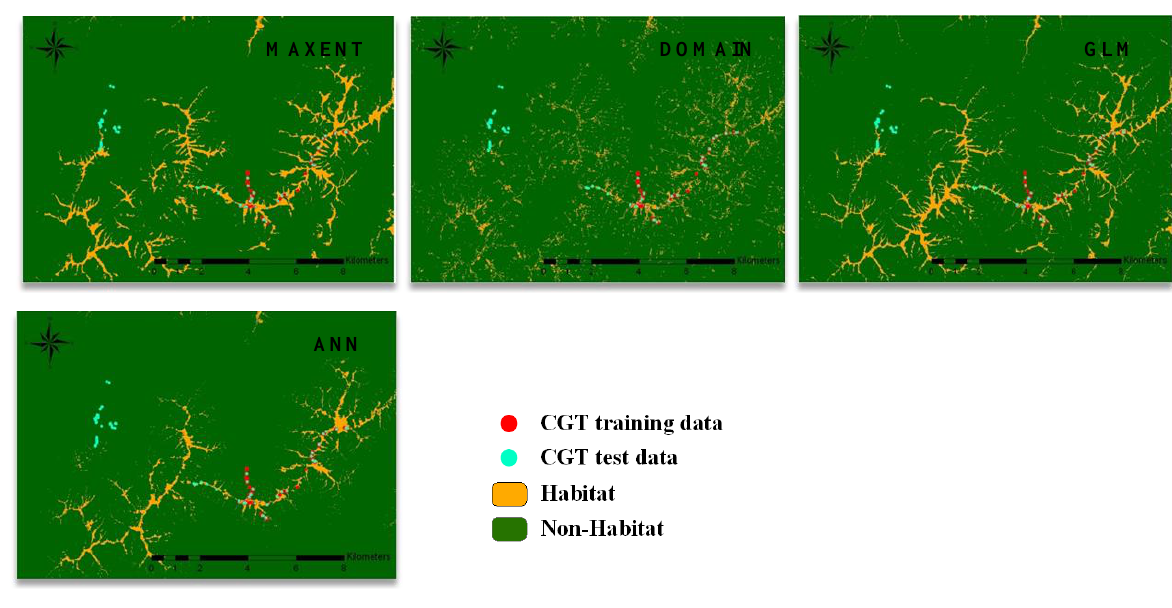
Figure 4. Sampling design 1: four models for mapping the potential habitat of CGTs in the study